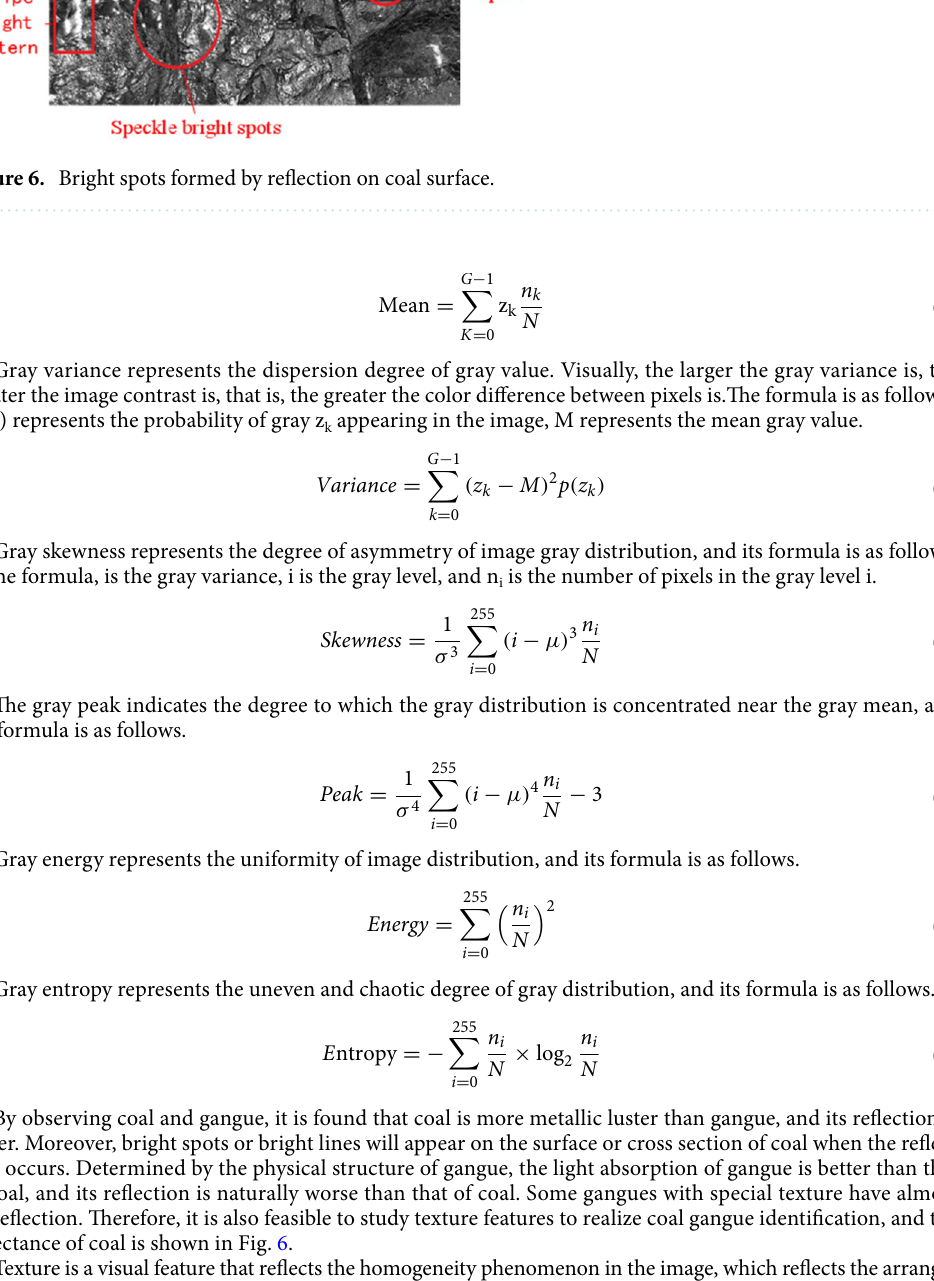
Gray entropy represents the uneven and chaotic degree of gray distribution, and its formula is as follows.